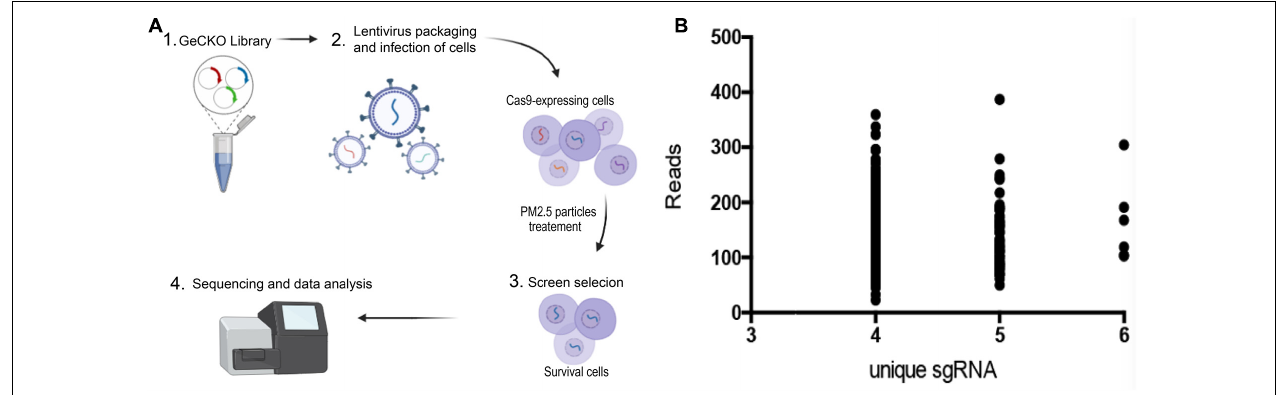
FIGURE 1 | Genome-wide CRISPR/Cas9-mediated forward genetic screening for identification of genes associated with PM2.5 resistance. (A) Schematic representation of forwarding genetic screening in L02 cells based on pooled sgRNA library. (B) PM 2 . 5 resistance genes identified after screening. Number of unique sgRNAs genes (X-axis) and changes in the number of reads of each sgRNA relative to controls